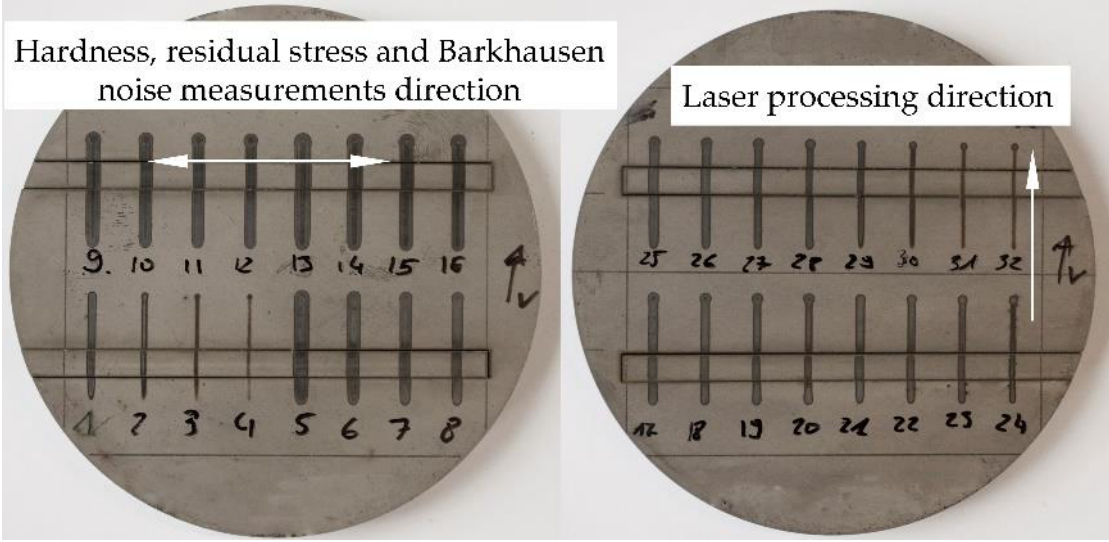
Figure 2. Tracks created by laser surface heating and the direction of surface hardness, residual stresses, and MBN measurements. The laser heating of the sample surfaces was performed using an Yb:YAG TRUMPF TruDisk 1000 laser (TRUMPF Laser GmbH + Co., Ditzigen, Germany) with a maximum power of 1 kW and wavelength λ = 1030 nm. The diameter of the beam on the surface of the workpiece was 2 mm. Prior to the laser heating, the surface was cleaned with 2-propanol. The processing parameters applied were as follows: laser power P —80–320 W, and scanning velocity v —250–1250 mm · min − 1 . The power density of the laser beam was in the range of 2.5–7.2 kW · cm − 2 . The process was carried out in an air atmosphere. The local laser irradiation of the workpiece sample generated a series of tracks 30 mm in length (Figure 2) on the surface. For further investigation the tracks exhibiting thermal effects such as oxidation, over-tempering, and re-hardening were selected (Table